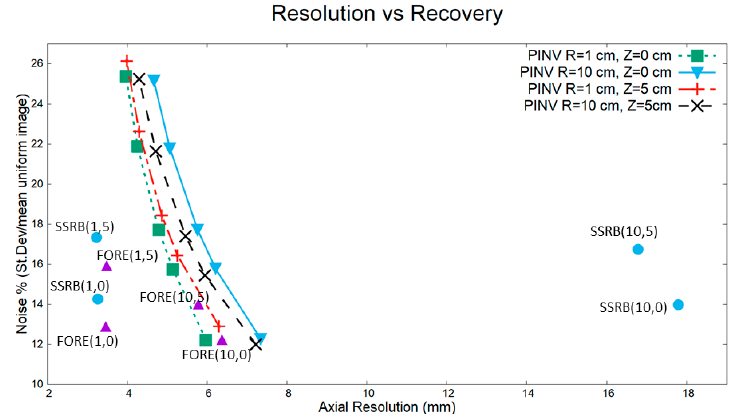
Figure 5. Noise vs. resolution recovery for different rebinning methods (SSRB, FORE, and PINVz). Point sources were simulated in a scanner with a geometry similar to Biograph TPTV with MRD 38 and SPAN 11. Numbers in brackets at the FORE and SSRB points indicate the distance (R,Z) to the center of the scanner in cm, for example, (10,0) represents a source at a radial distance of 10 cm from the center of the scanner at the axis. Several points for PINVz show the axial resolution vs. recovery for a different Landweber iterations, from right to left 5, 8, 10, 15, and 20 iterations. Outside the axis of the scanner, SSRB was not accurate, while FORE provided the best results overall, although with some sensitivity to distance to the scanner axis. PINVz keeps a more uniform resolution across the whole FOV.